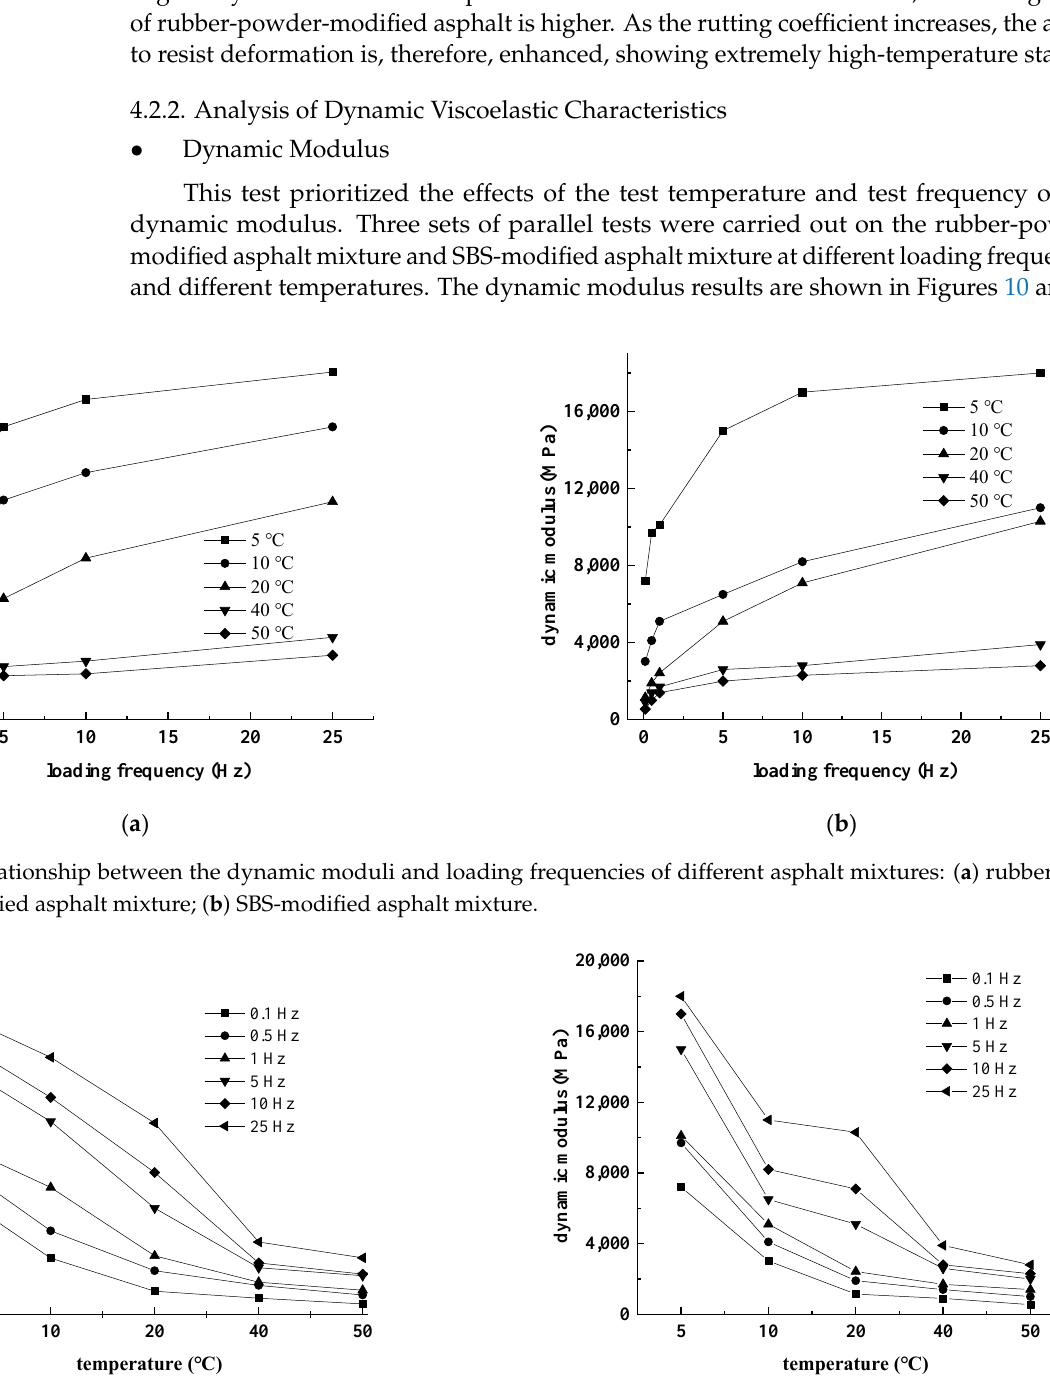
Figure 11. Relationship between the dynamic moduli and temperatures of different asphalt mixtures: ( a ) rubber-powder- modified asphalt mixture; ( b ) SBS-modified asphalt mixture.